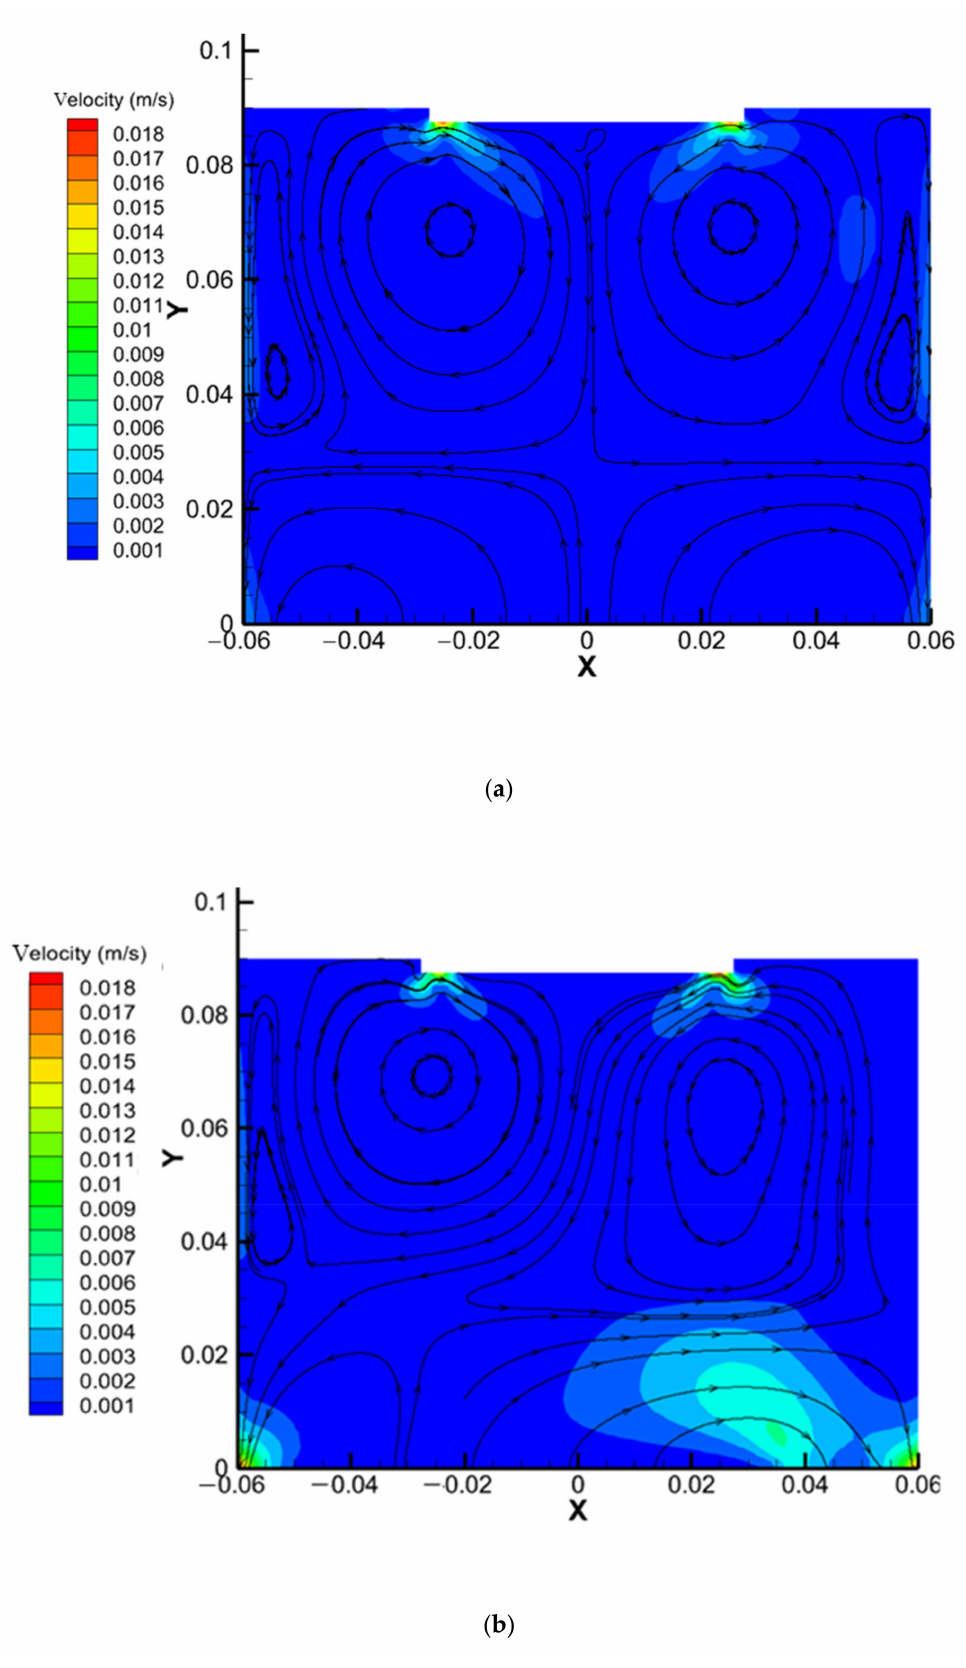
Figure 4. Flow field and streamlines distribution with ( a ) vibrating electrode (t = 10 s) ( b ) conventional electrode (t = 10